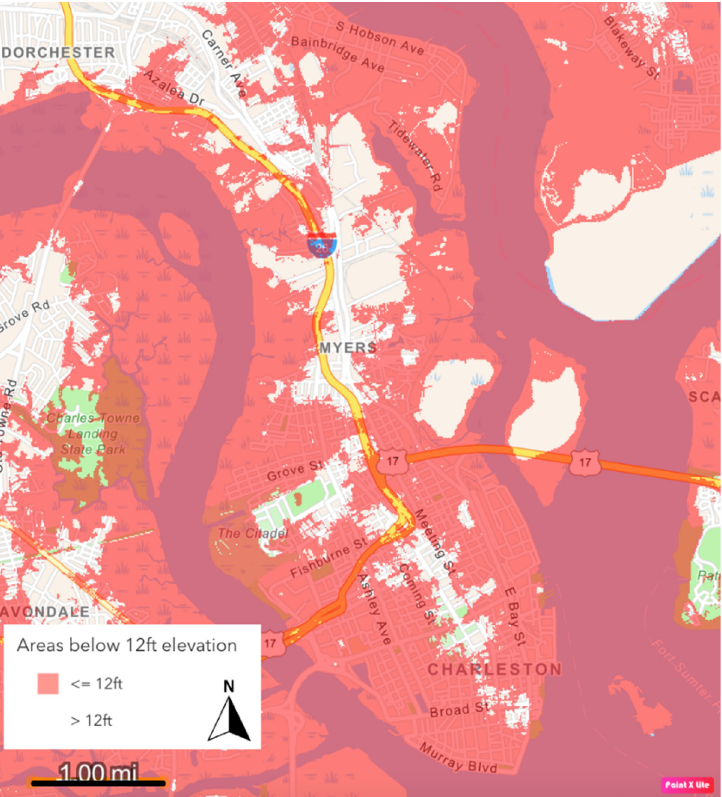
Figure 3. Parts of the Charleston peninsula that are <12 ft (3.7 m) elevation (in red). Digital Elevation Model (DEM) developed by the Lowcountry Hazards Center at the College of Charleston.